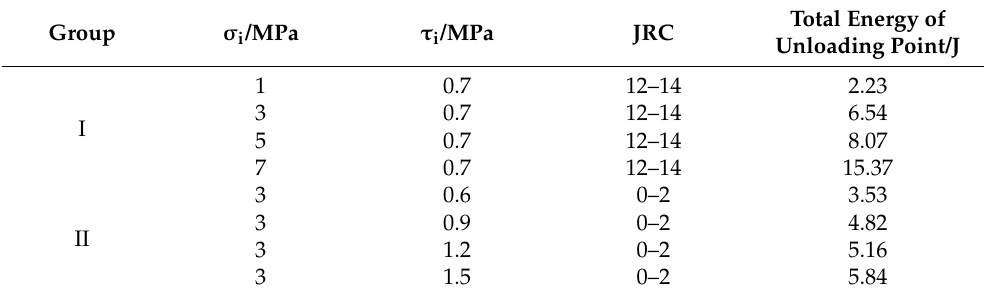
Table 4. Total energy of unloading point under different initial stress conditions.